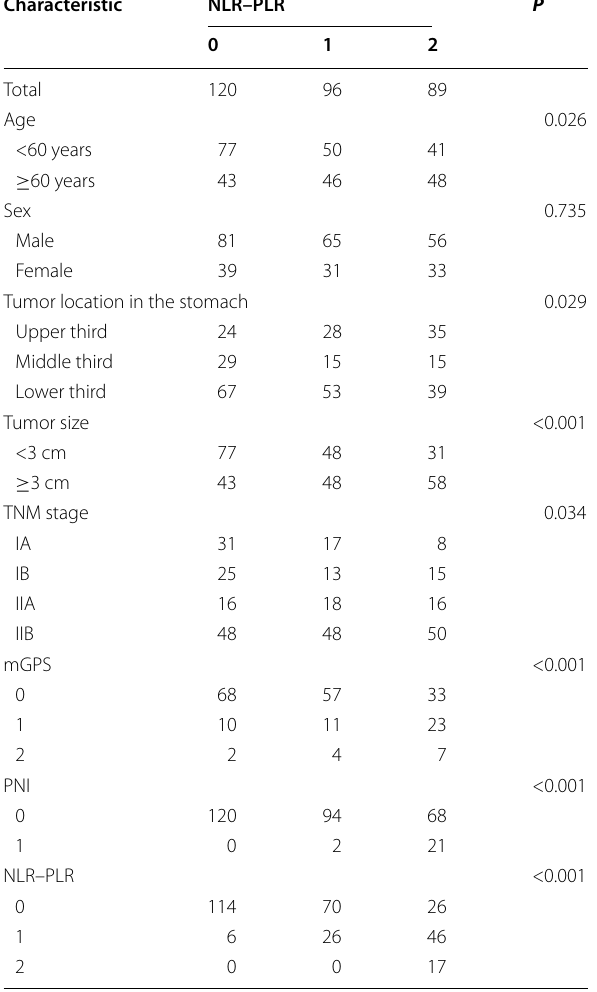
Table 2 Relationships between NLR–PLR and clinicopatho- logic characteristics of 305 patients with stage I–II gastric cancer